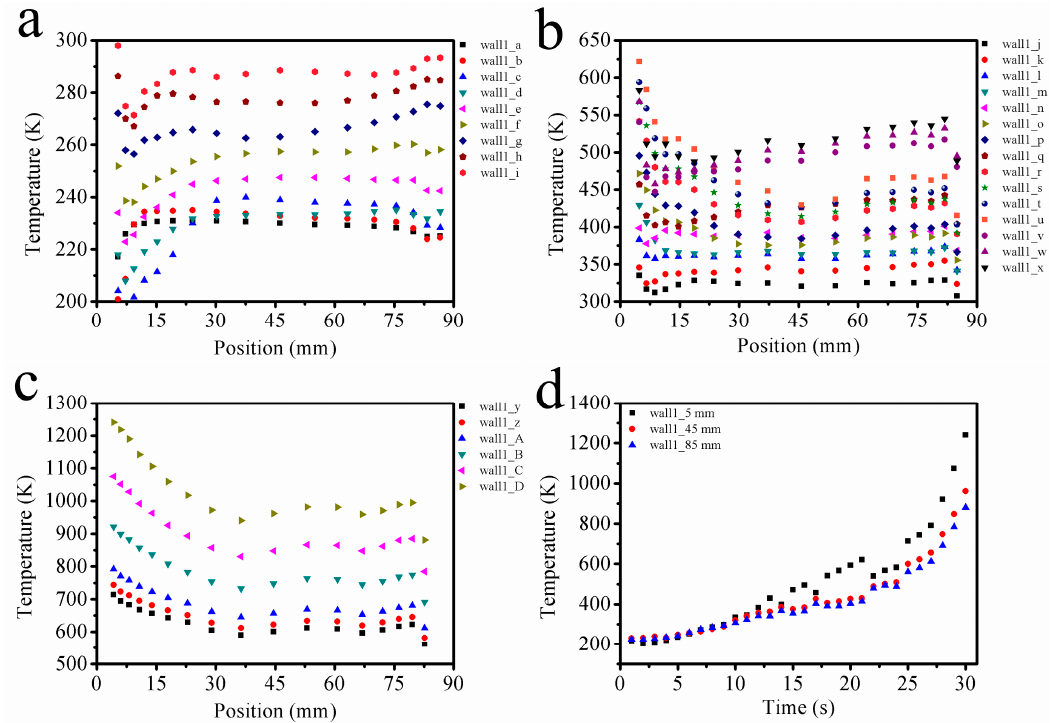
Figure 9. ( a – c ) The scatter graphs of Wall 1 between positions and temperature values and ( d ) the fitting curves.